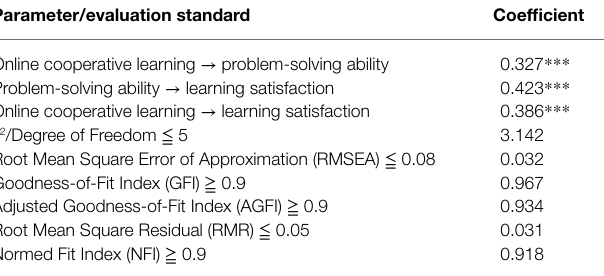
TABLE 1 | Structural equation modeling